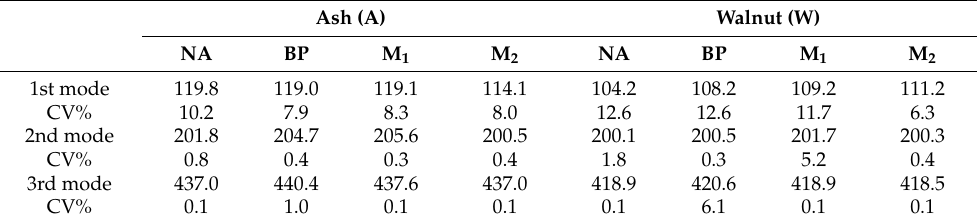
Table 3. Modal frequencies in Hz of electric guitar with body from ash—(A) and walnut wood (W) (NA—8th fret of the fingerboard; BP—body pickup; M 1 —body microphone; M 2 —edge body microphone; CV%—Coefficient of